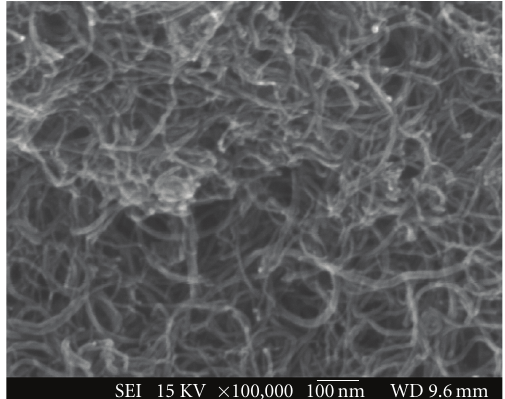
Figure 1: SEM image of MWCNTs film on a GCE.